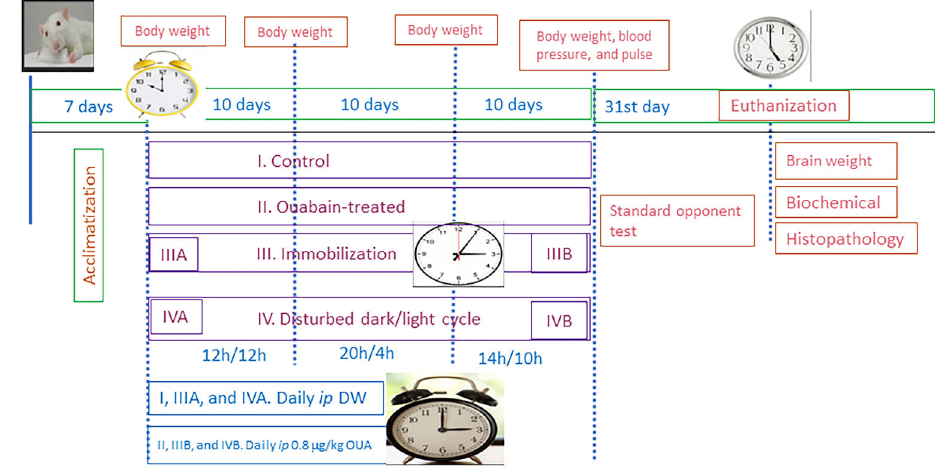
Figure 1. Experimental design. After 7-day acclimatization, adult male Wistar albino rats (7 – 8 months of age) (N=30) were subdivided into 4 main groups, Control I (n=5), Ouabain-treated II (n=5), Immobilization stress III (n=10), and Disturbed dark/light cycle IV ( n=10). In Immobilization (III), rats were restrained every other day for 1 h in a restrainer for 30 days. In Disturbed dark/light cycle (IV), rats were subjected to dark/light (12/12 h for the fi rst 10 days), dark/light (20/4 h for the next 10 days), and then dark/light (14/10 h for the last 10 days). Each of the two subgroups III and IV was further subdivided, equally, into either A (untreated, n=5) or B (ouabain-treated, n=5). In groups I, IIIA, and IVA, rats were administered distilled water (DW) ip daily at a volume of 0.36 mL/200 g body weight for 30 days; in groups II, IIIB, and IVB, they were given ouabain (OUA) ip at a dose of 0.36 m g/200 g body weight daily for 30 days. Animals were weighed initially, and at the 10th, 20th, and 30th days. At day 30, blood pressure and pulse were recorded. At day 31,